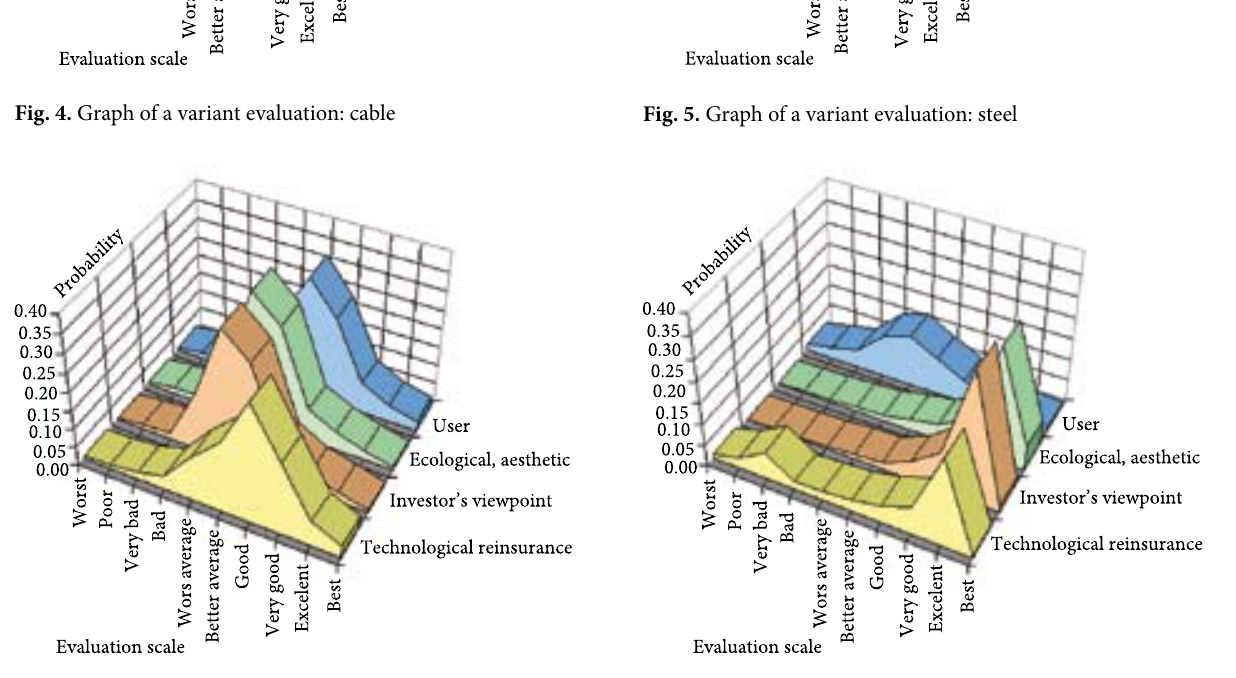
Fig. 7. Graph of a variant evaluation: non barriers